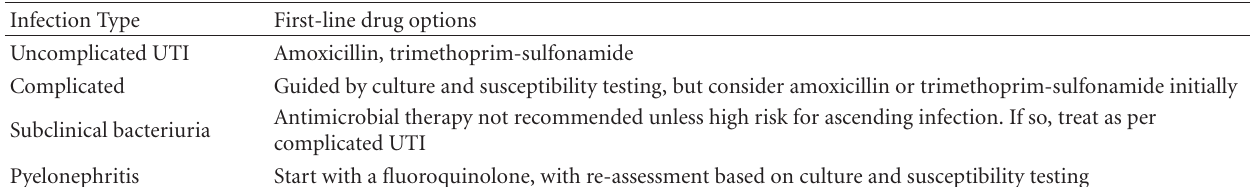
Table 1: Summary of first-line antimicrobial options for UTIs in the dog and